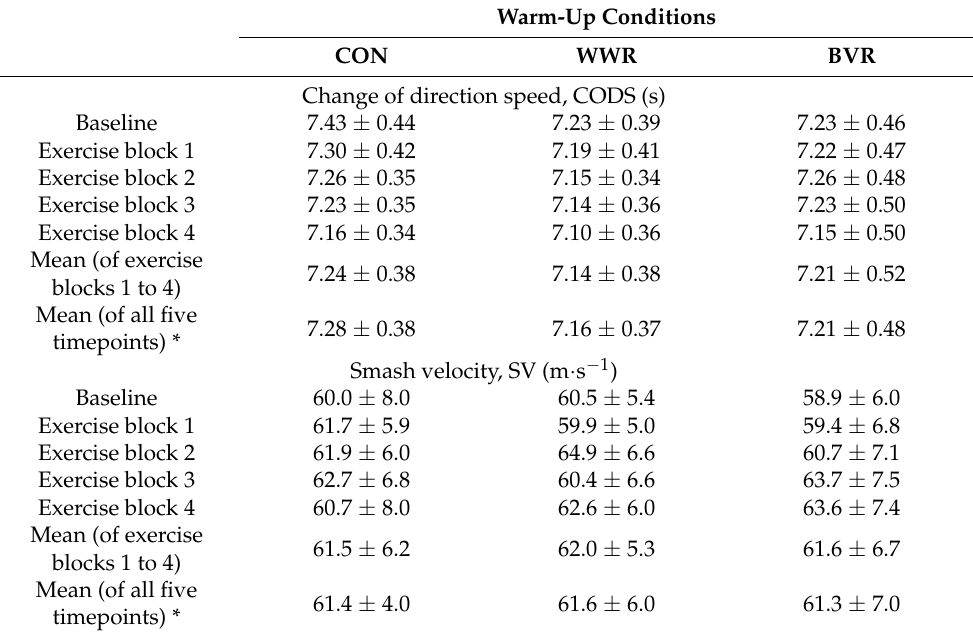
Table 2. Descriptive statistics of change of direction speed (CODS) and smash velocity (SV) per- formance tests of the control (CON), weighted wearable resistance (WWR), and banded variable resistance